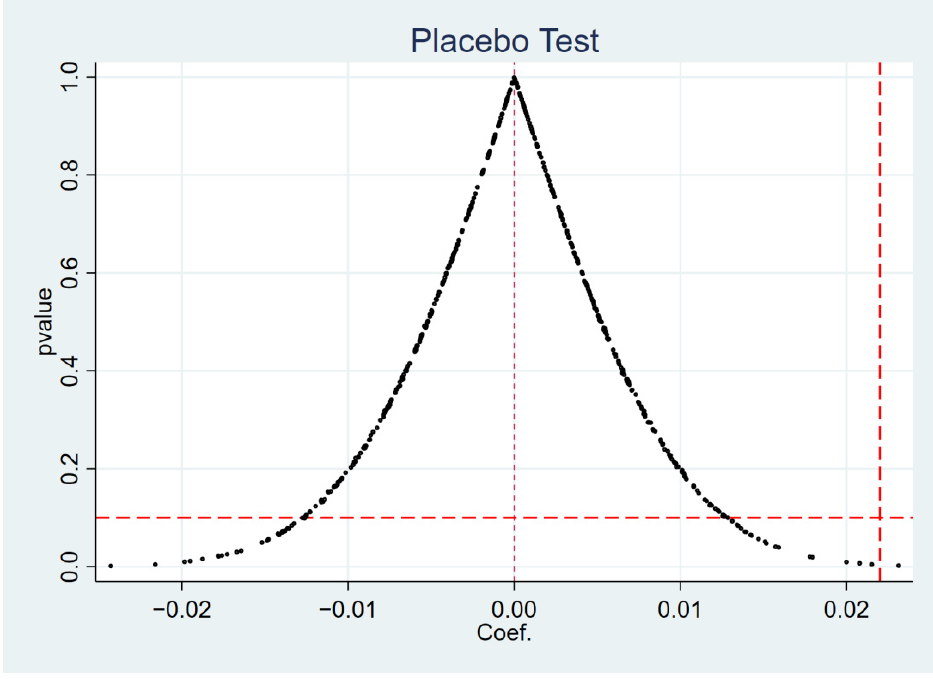
Figure 3. Placebo test for short-term debt financing.